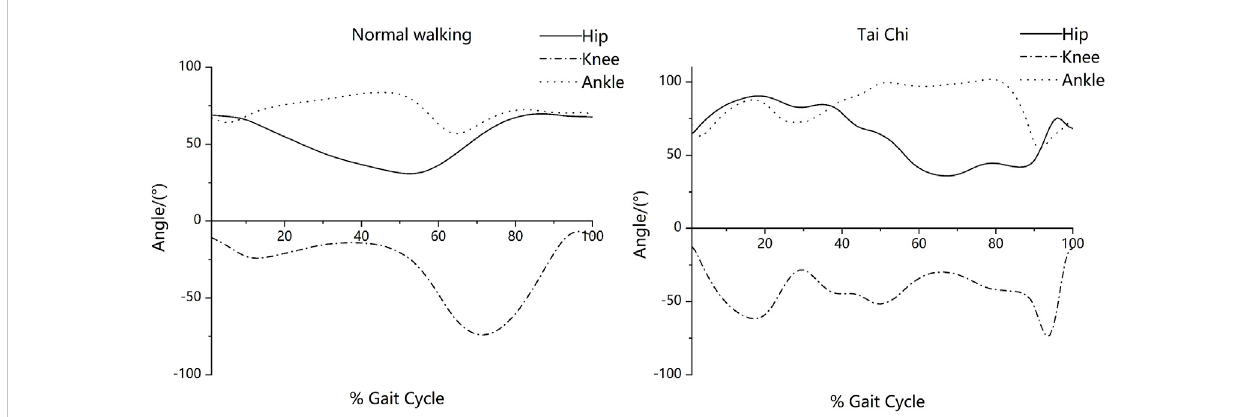
Angles of lower limb joints in the sagittal plane for normal walking and Tai Chi movements.